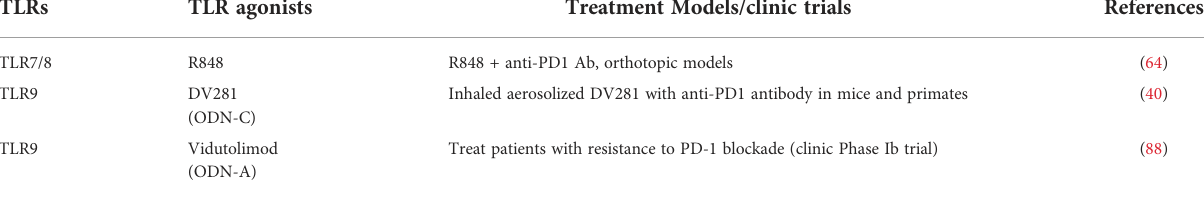
TABLE 3 Combination of TLR agonists with checkpoint inhibitors for lung cancer treatment. TLRs